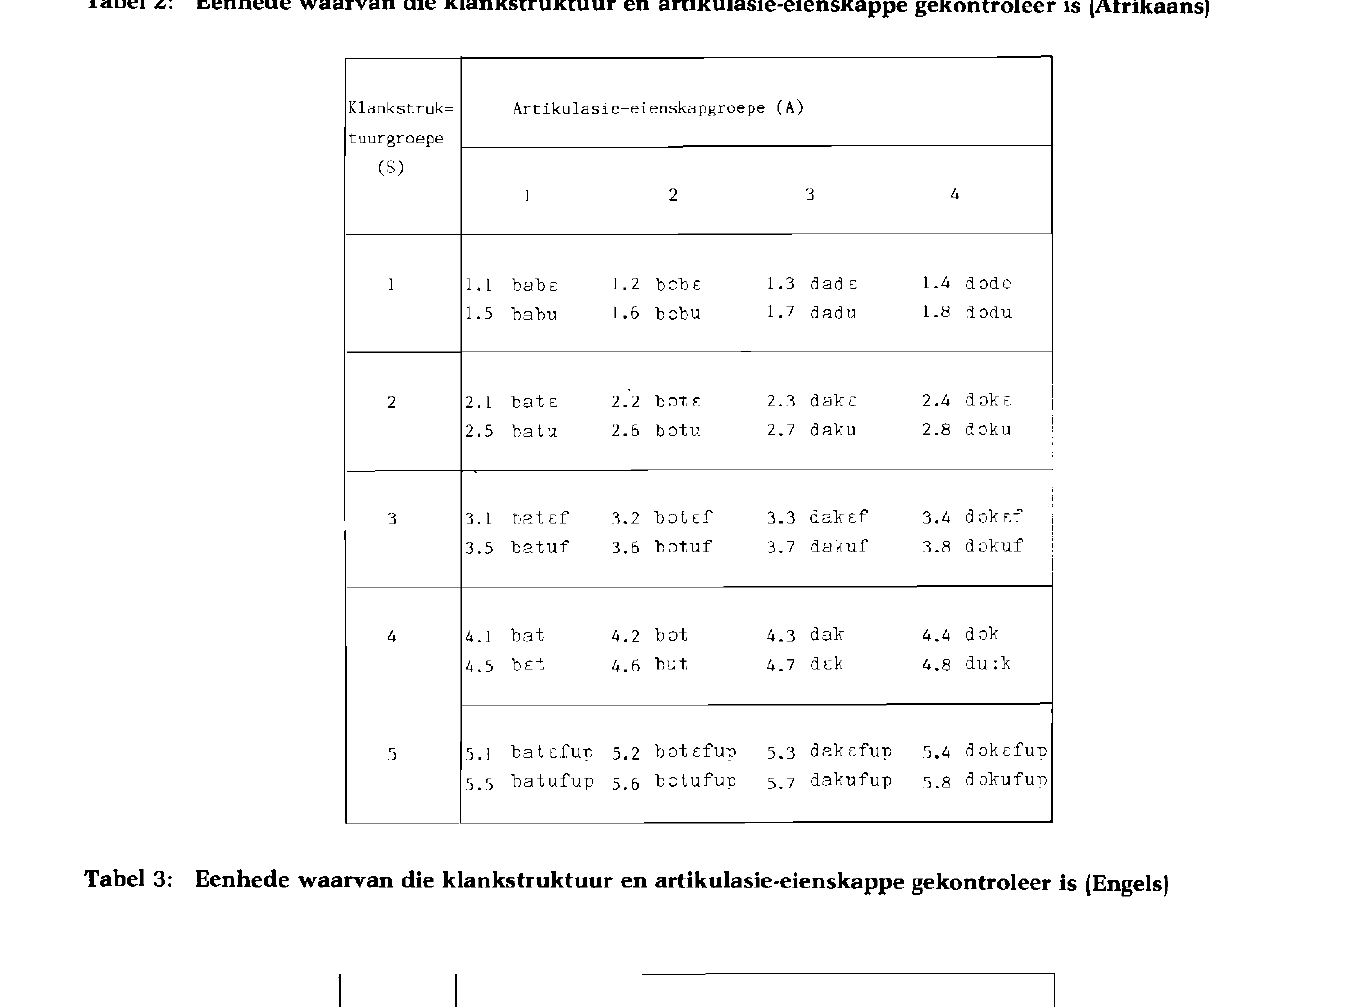
Tabel 2: Eenhede waarvan die klankstruktuur en artikulasie-eienskappe gekontroleer is (Afrikaans)